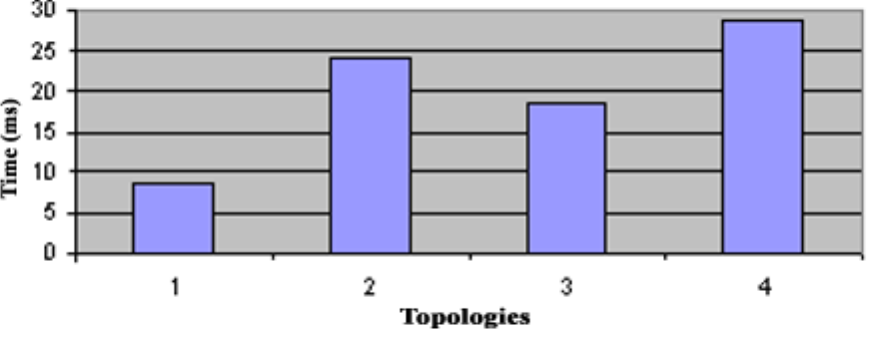
Figure 8. Comparison of Convergence